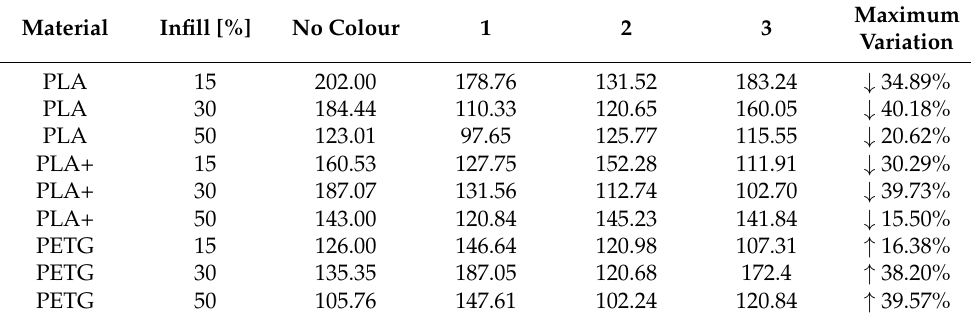
Table 8. Uncoloured test values/Sq Table 7. Degree of variation for Sq roughness.